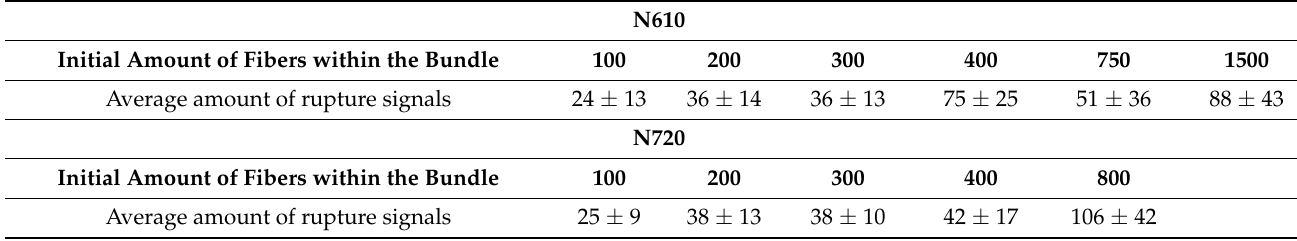
Table 4. Average rupture signal amounts and standard deviation for the different fiber types and initial amount of fibers.